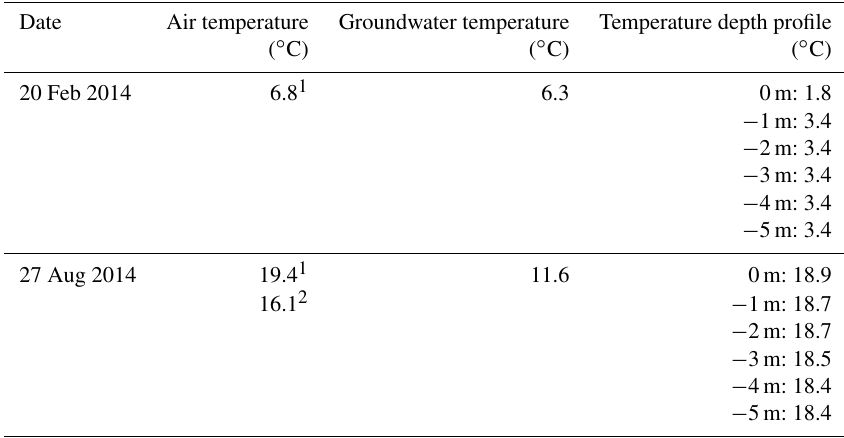
Table 2. Groundwater temperatures and lake water temperature depth profiles measured during FO-DTS